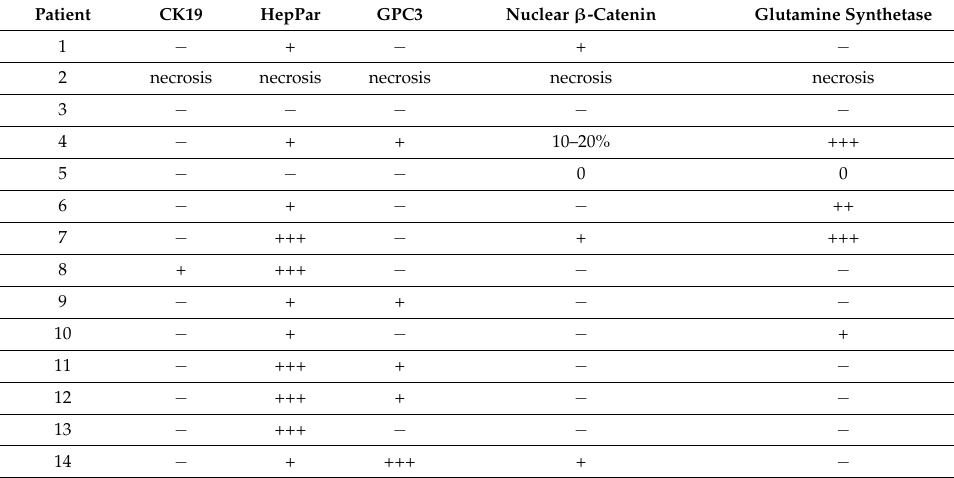
Table 3. Immunohistochemical characteristics of the